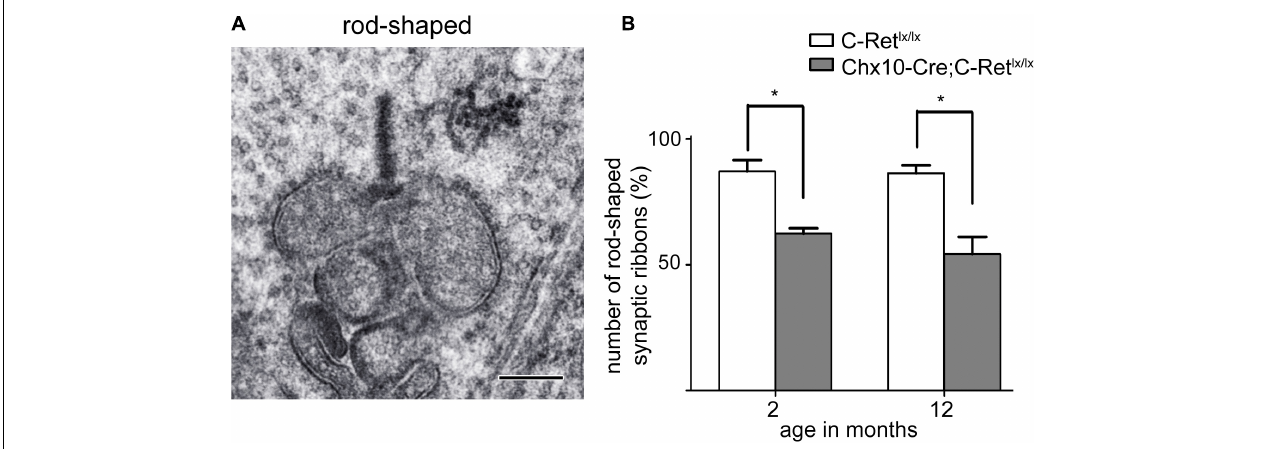
FIGURE 9 | Rod-shaped synaptic ribbons of photoreceptors disintegrated in Chx10-Cre;C-Ret lx / lx mice. (A) A typical rod-shaped synaptic ribbon is shown in the large presynaptic terminal. Scale bar: 300 nm. (B) Quantification was performed to investigate the number of rod-shaped synaptic ribbons in retinae of C-Ret lx / lx and Chx10-Cre;C-Ret lx / lx mice at the age of 2 and 12 months. The histogram was plotted using mean values ± standard error of the mean (SEM). * Denotes p < 0.05 in Student’s t -test ( n =